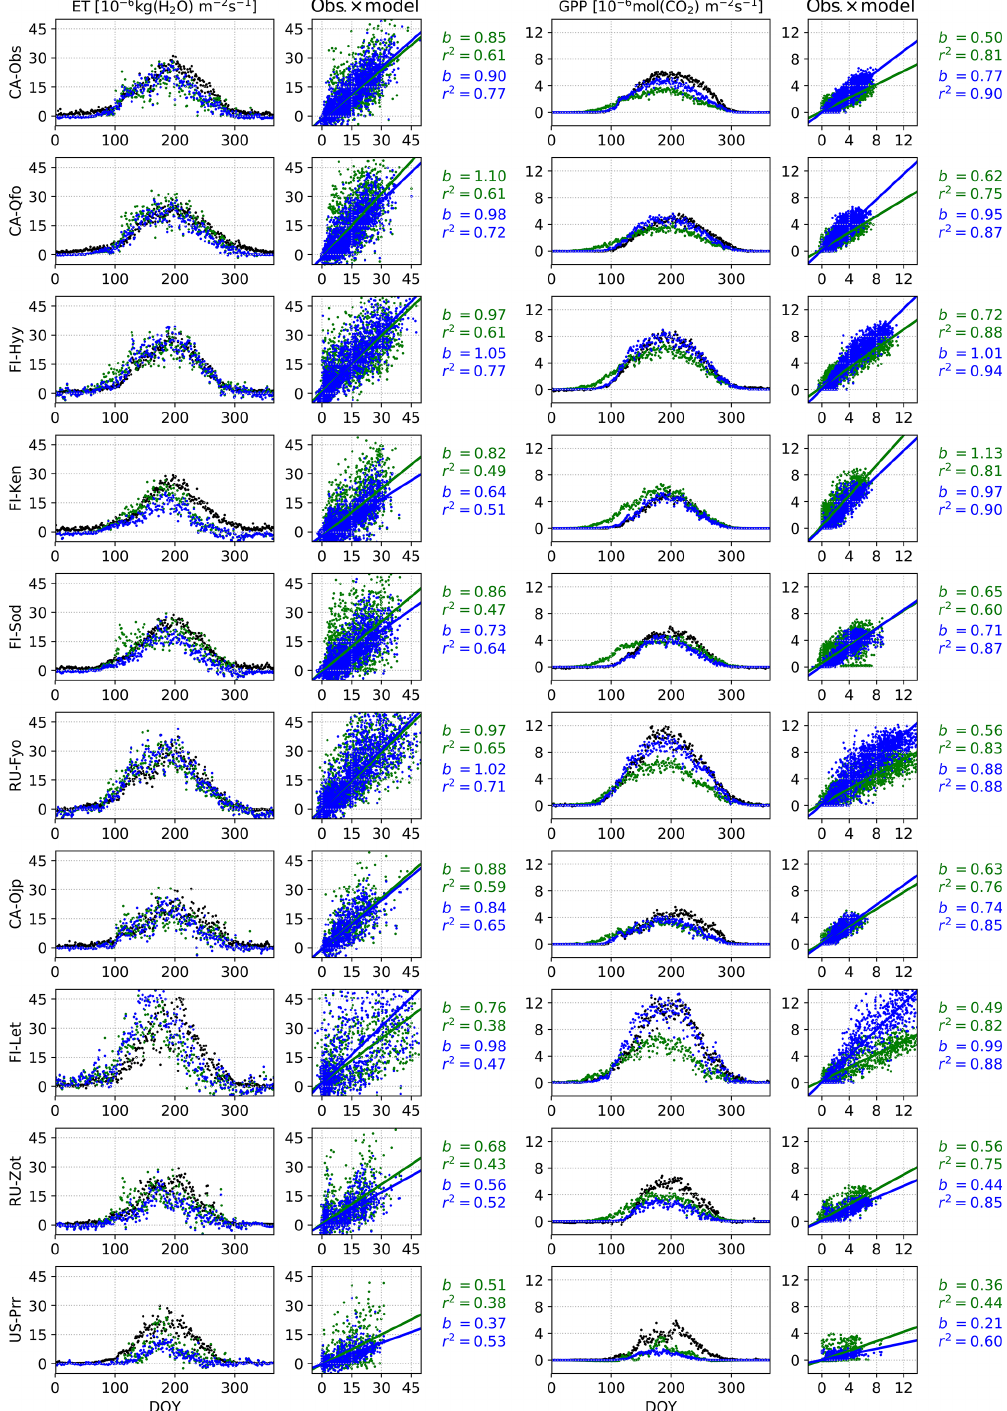
Figure 2. Validation period average annual cycles of evapotranspiration and gross primary production; observations (black) and the model using the Bethy stomatal conductance formulation with default (green) and optimised (blue) parameterisation. Also presented are daily model values cross plotted against observations with corresponding slope of the regression line ( b ) and the coefficient of determination ( r 2